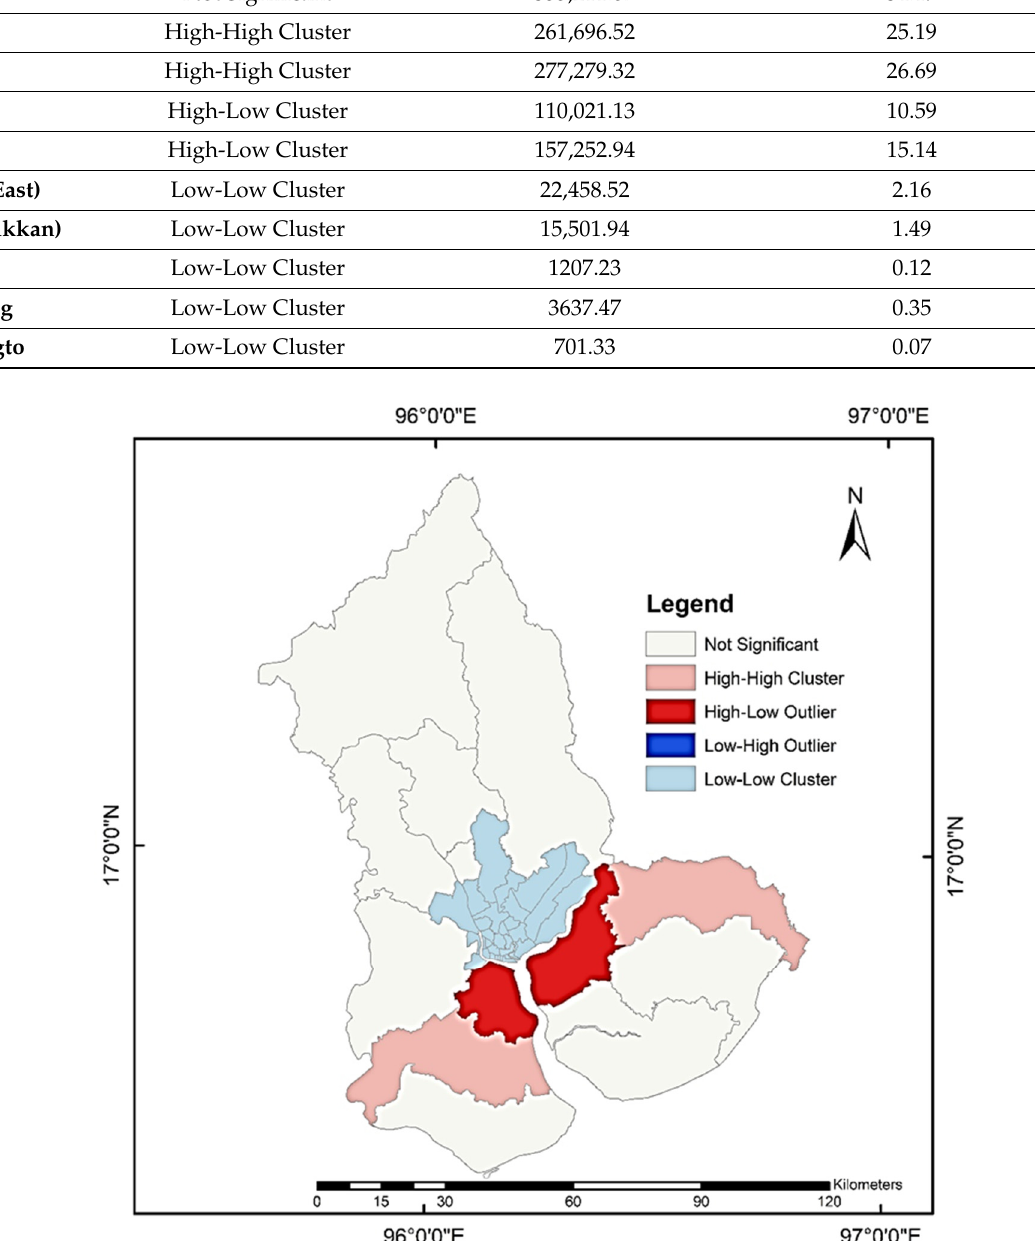
Figure 6. Township-based clusters for rice straw. Table 2. The Results of Township-Based Clusters Analysis of the Feedstock of the Rice Straw.